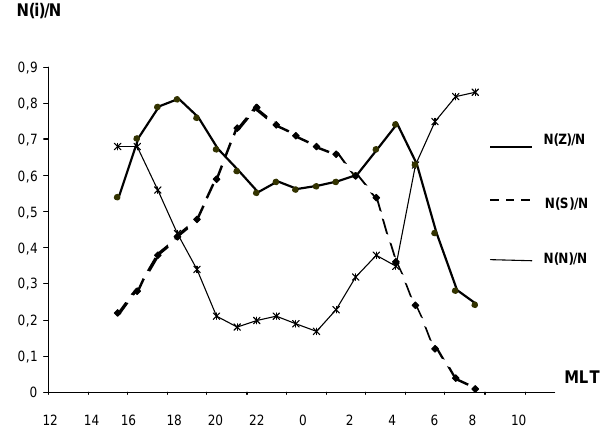
Fig. 10. Daily variation of relative occurrence of aurora for different Figure 10. Daily variation of relative occurrence of aurora for different look directions at look directions at Spitsbergen. Spitsbergen.